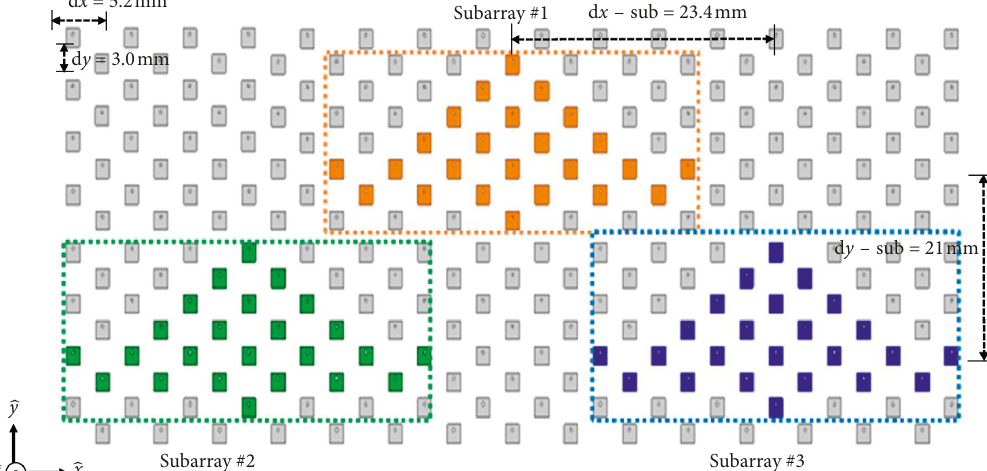
Figure 1: Configuration of the proposed array formed of three 24-element triangular-grid diamond-shaped subarrays. In the array, d x � 5.2mm and d y � 3.0mm.